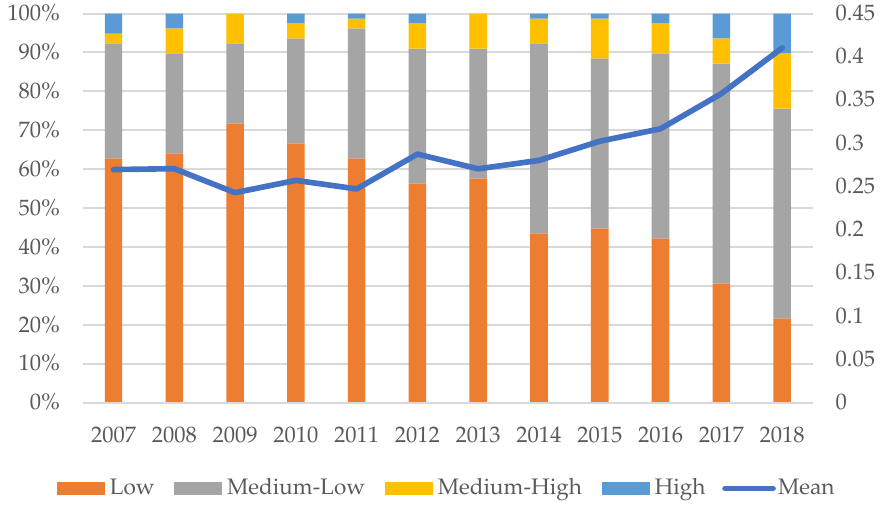
Figure 2. Evolution trend of the ECILUs in